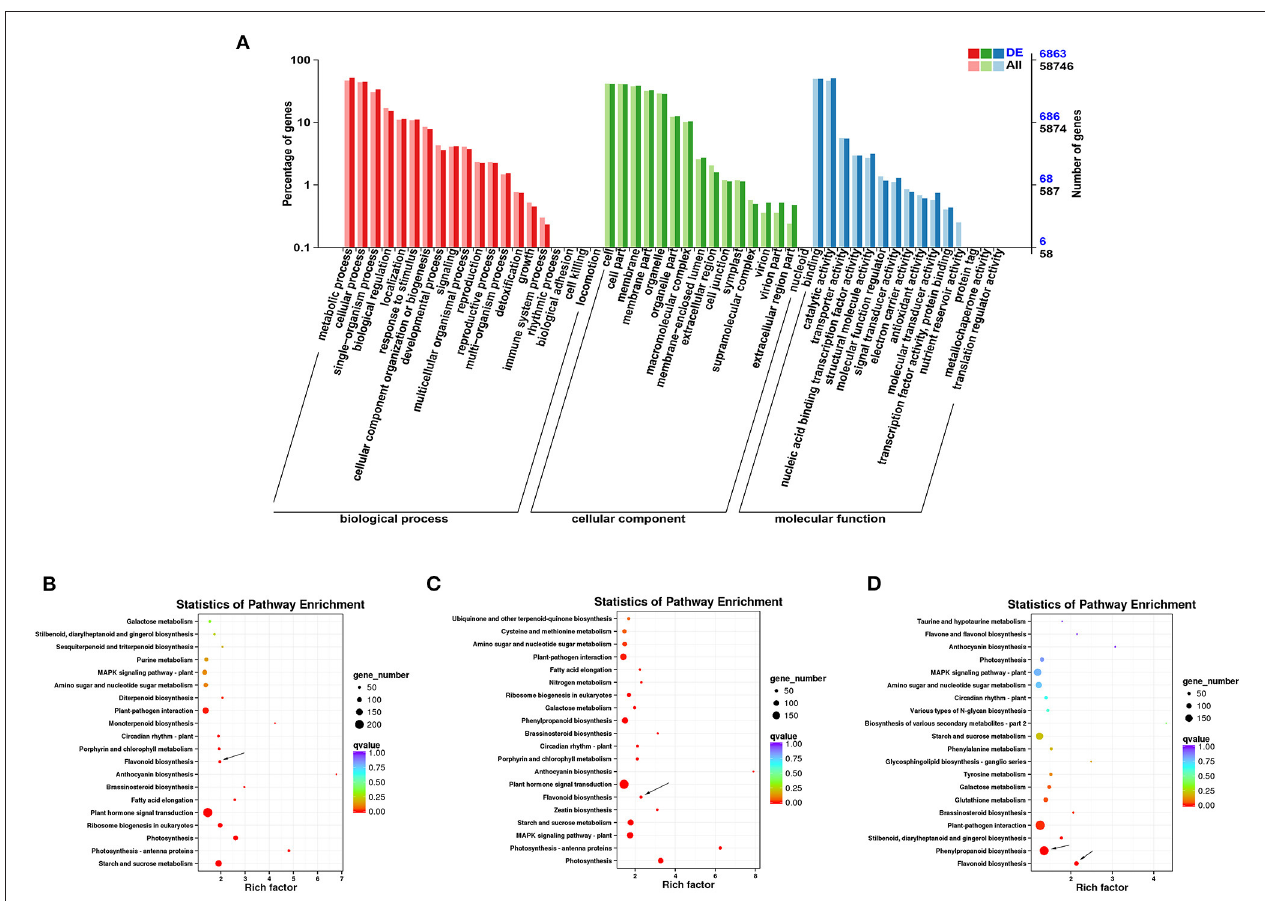
FIGURE 4 | Functional annotation of DEGs in ZBLs under drought stress. (A) : Gene ontology (GO) annotation of DEGs in FJ and HJ under drought stress. (B–D) : KEGG enrichment analysis of DEGs in F1 vs. F4, H1 vs. H4, and F4 vs. H4. Dot size represents the number of distinct genes, and dot color reflects the q -value.